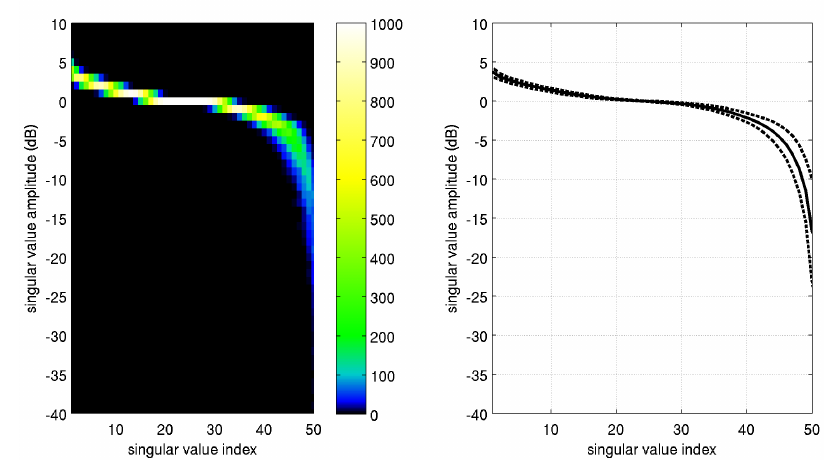
Figure 9. Singular values analysis for d = 2 λ and K = 50. ( Left ) Image map of the distribution of each one of the 50 singular values. ( Right ) solid line, average singular values; dashed lines, average singular values ± the standard deviation of the